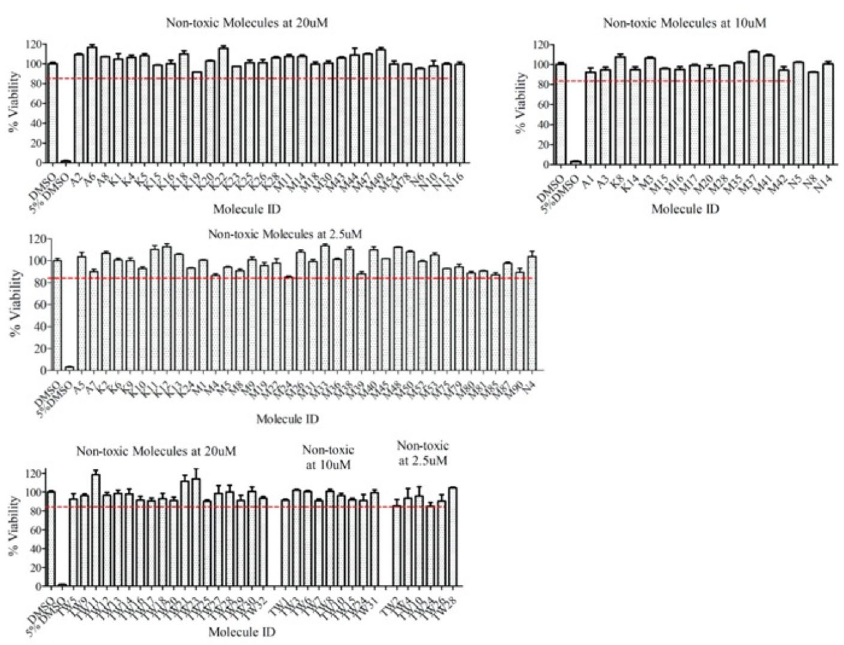
Figure 2. Non-toxic dosages of molecules determined by MTT toxicity assay. The cell viability was measured in cells treated with different concentrations of molecules. A dose of a molecule that allowed > 90% of cell survival evaluated as non-toxic dose. (Data represent the mean ± SEM n = 3). Cells were seeded 96-well plate and grown for 48 h. Then, cells were treated with molecules with indicated concentrations or solvent (DMSO) as control (final volume of DMSO is 0.5%). After 48 h of treatment, medium was replaced with DMEM: MTT reagent mix and incubated for 4 h. Finally, formazan salts dissolved in ethanol: DMSO mix and absorbance values of each well were measured at 570 nm using Synergy H1 (BioTek). The viability of DMSO-treated cells was normalized to 100% and the relative viability of cells treated with molecules was reported. A group of cells treated with 5% DMSO, known as toxic to cells, used as a positive